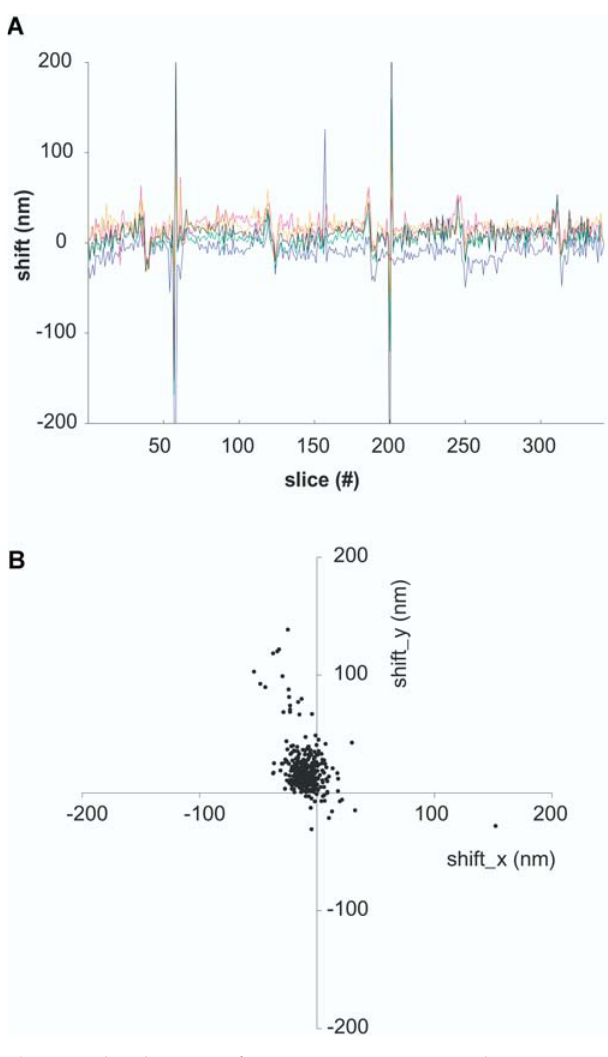
Figure 4. The Alignment of Successive Images in a Stack Shifts between images were quantified using the positions of the peaks of the cross correlation (see Materials and Methods); same dataset as in Figure 3A and 3B. (A) The peak shifts in x-direction are shown for five different subregions distributed over the field of view. Four of the regions have a size of 256 3 256 pixels, one has a size of 512 3 512 (black trace). The peaks around slices 59 and 202 are caused by slice debris on the block face (see also streaks in Figure 3B). (B) The x/y displacement for the 512 3 512 region is shown in a scatter plot. For the central cluster the standard deviations are 10.9 nm and 11.8 nm for x and y, respectively. DOI: